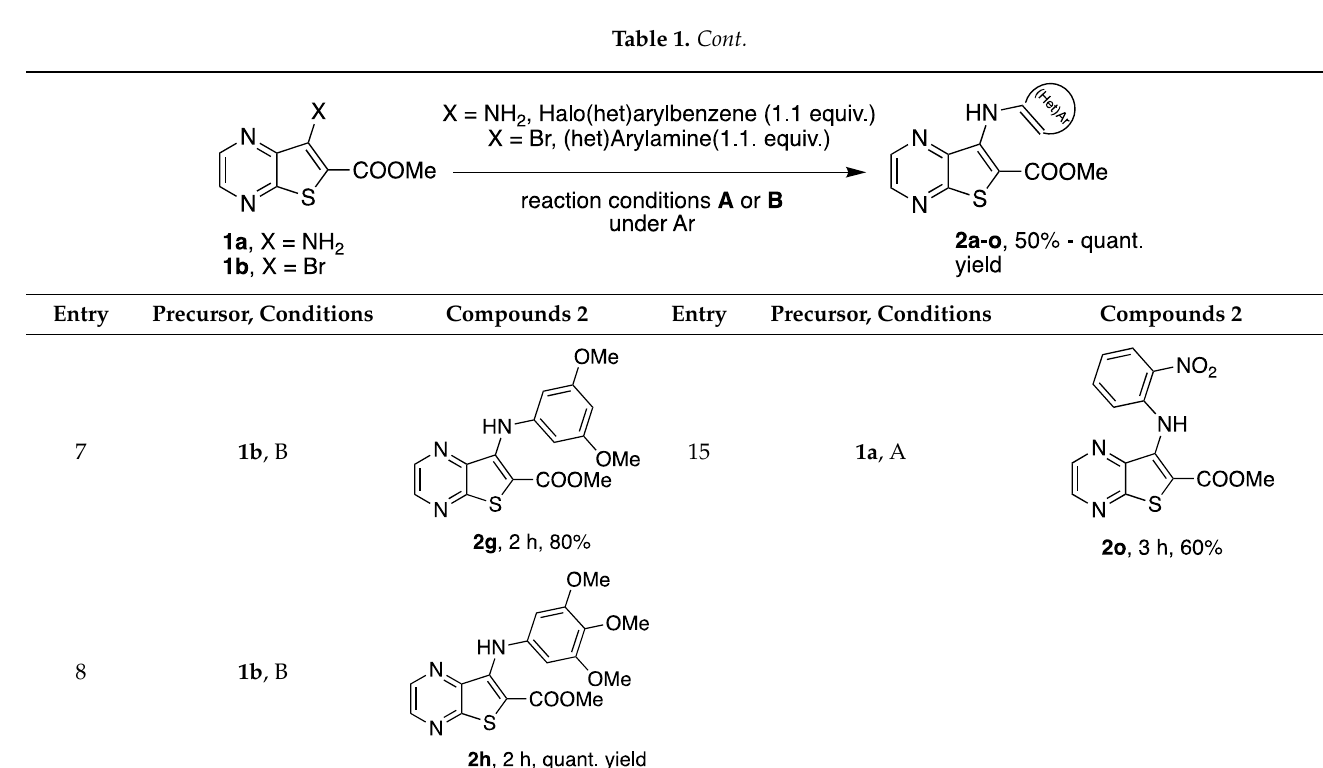
man tumor cell lines and in a non-tumor cell 1